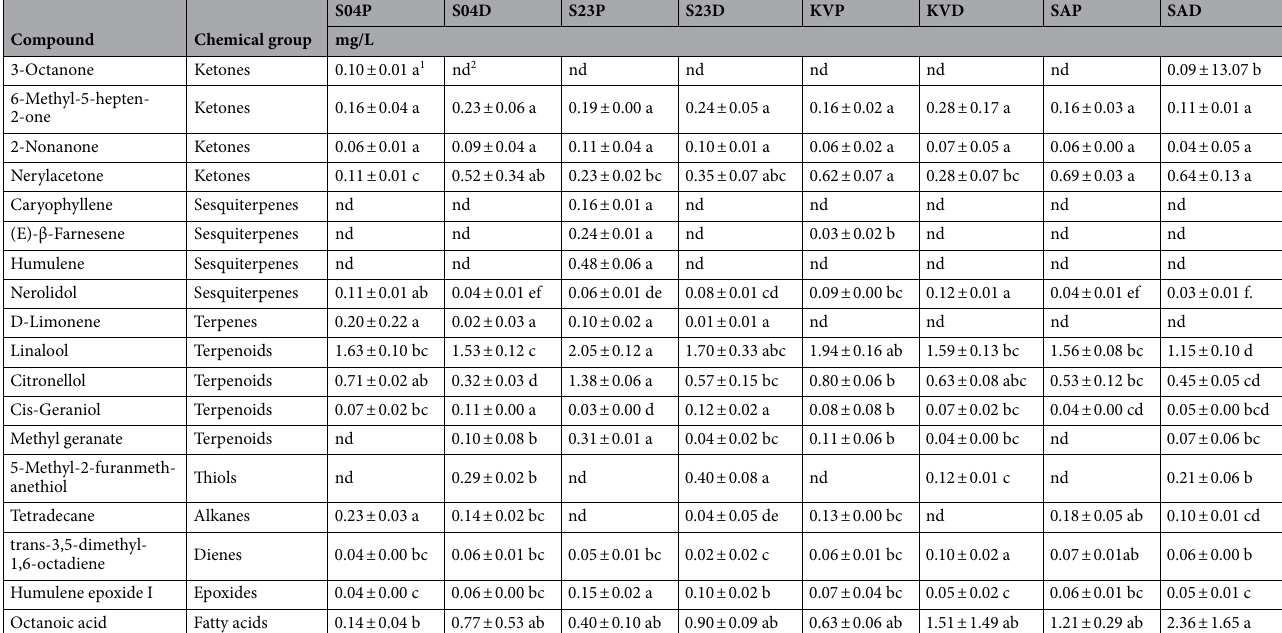
Table 4. Concentration of ketones, terpenes and terpenoids and other compounds identified in beers by GC-MS. 1 Values are expressed as mean (n = 2) ± standard deviation. The mean values with different letters (a, b, c, d, e, f) within the same row are statistically different ( P < 0.05). 2 nd—not